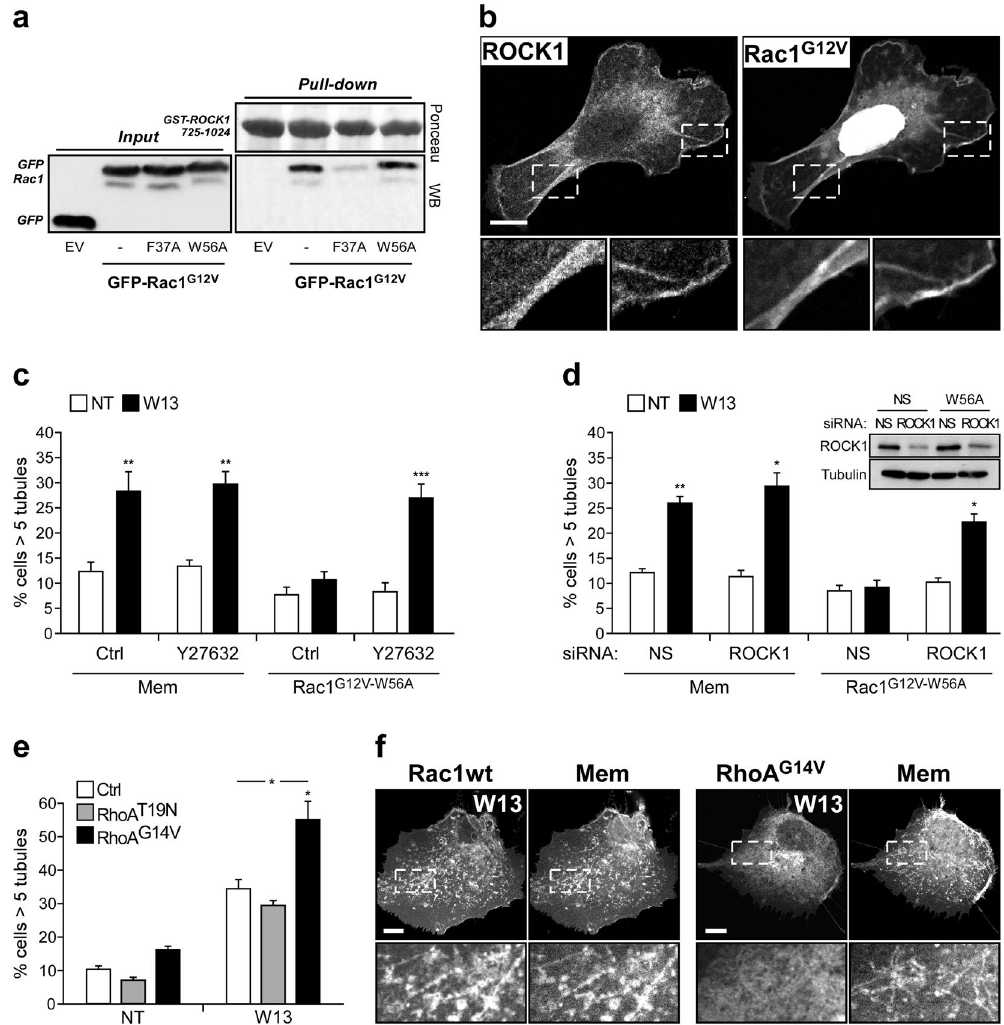
Figure 6. Rac1/ROCK1 pathway prevents tubulation without altering PM localization of cortactin. ( a ) Lysates of COS1 cells expressing GFP-Rac1 G12V , GFP-Rac1 G12V-F37A , GFP-Rac1 G12V-W56A or the empty GFP-C1 vector (EV) were incubated with immobilized GST-ROCK1 725–1024 in glutathione Sepharose beads, as described in the Materials and Methods . GFP-Fusion proteins present in the input lysates and in the bound fraction were detected by western blotting, using an anti-GFP antibody. A representative western blotting is shown (n = 3). ( b ) Vero cells were co-transfected with cherry-Rac1 G12V and GFP-ROCK1. Confocal image insets show regions with high co-localization. ( c , d ) COS1 cells were transfected with GFP-Rac1 G12V-W56A and treated with or without W13 (20 min, 4.5 µ g/ml). The percentage of cells presenting tubules was determined after the inhibition of ROCK1 activity with Y27632 ( c ) or after the inhibition of ROCK1 expression by transfection with a specific siRNA ( d ). Downregulation of ROCK1 expression by its specific siRNA is shown by western blotting. ( e ) The percentage of cells presenting tubules was determined in untreated and W13-treated COS1 cells expressing GFP-RhoA T19N , GFP-RhoA G14V , or GFP-mem as a control. Mean values ± standard error of the mean (SEM) from three independent experiments are shown in all cases. Statistical significance between different conditions was determined by Student’s t -test, * p < 0.05, ** p < 0.01, *** p < 0.001. ( f ) Vero cells co-transfected with Cherry-mem and GFP-Rac1 (left panel) or GFP-RhoA G14V (right panel) were treated with W13. Images and insets show localization of GFP-Rac1, but not of GFP-RhoA G14V , in the cherry-mem tubules. All images were acquired using the Leica TCS SP5 confocal microscope (bars, 10 µ